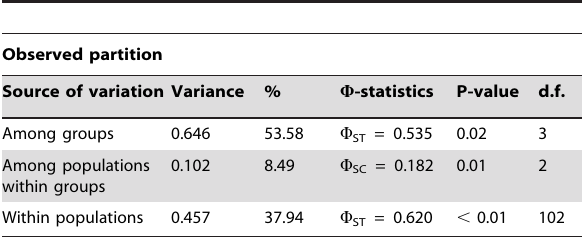
Table 4. Analysis of MOlecular VAriance (AMOVA) based on 28S rDNA sequence data for Oithona similis